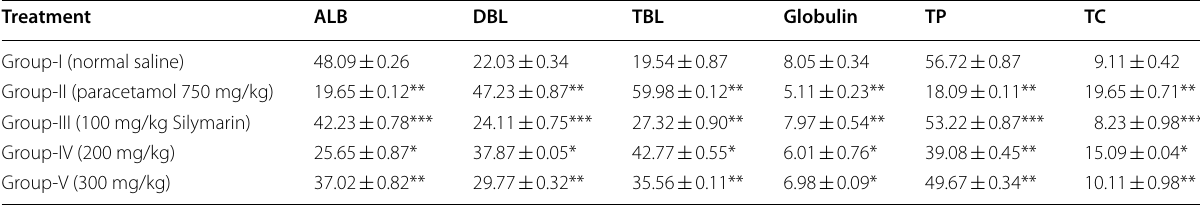
ALB: albumin; DBL: direct bilirubin; TBL: total bilirubin; TP: total protein; TC: total cholesterol Values are expressed as mean SEM, n 6 and were estimated using one-way ANOVA followed by post hoc Tukey HSD test. Comparisons are made between (1) ± = Group-I versus Group-II, (2) Group-II versus Group-III, IV and V. * p ˂ 0.05,** p ˂ 0.01,*** p ˂ 0.001 considered as significant